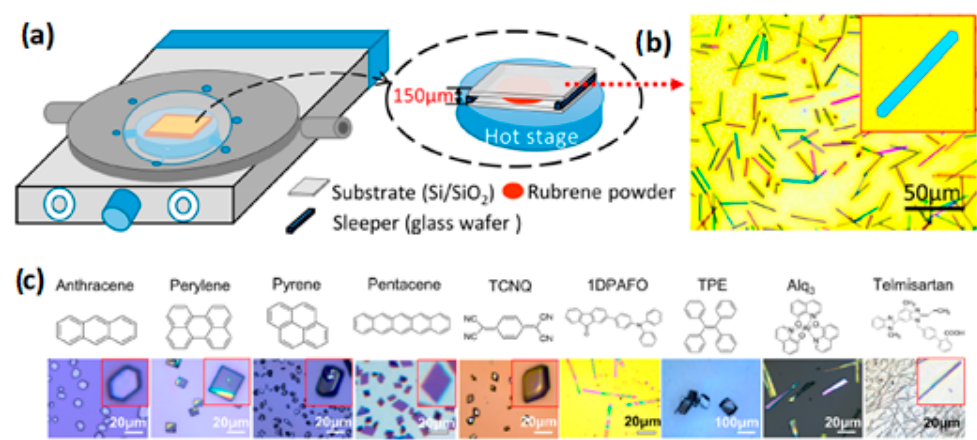
Figure 9. ( a ) Schematic representation of the microspacing sublimation technique. ( b ) Rubrene crystals grown from microspacing technique. ( c ) Crystals grown by microspacing sublimation. Reproduced with permission from ref. [86]. Copyright 2018, American Chemical Society.